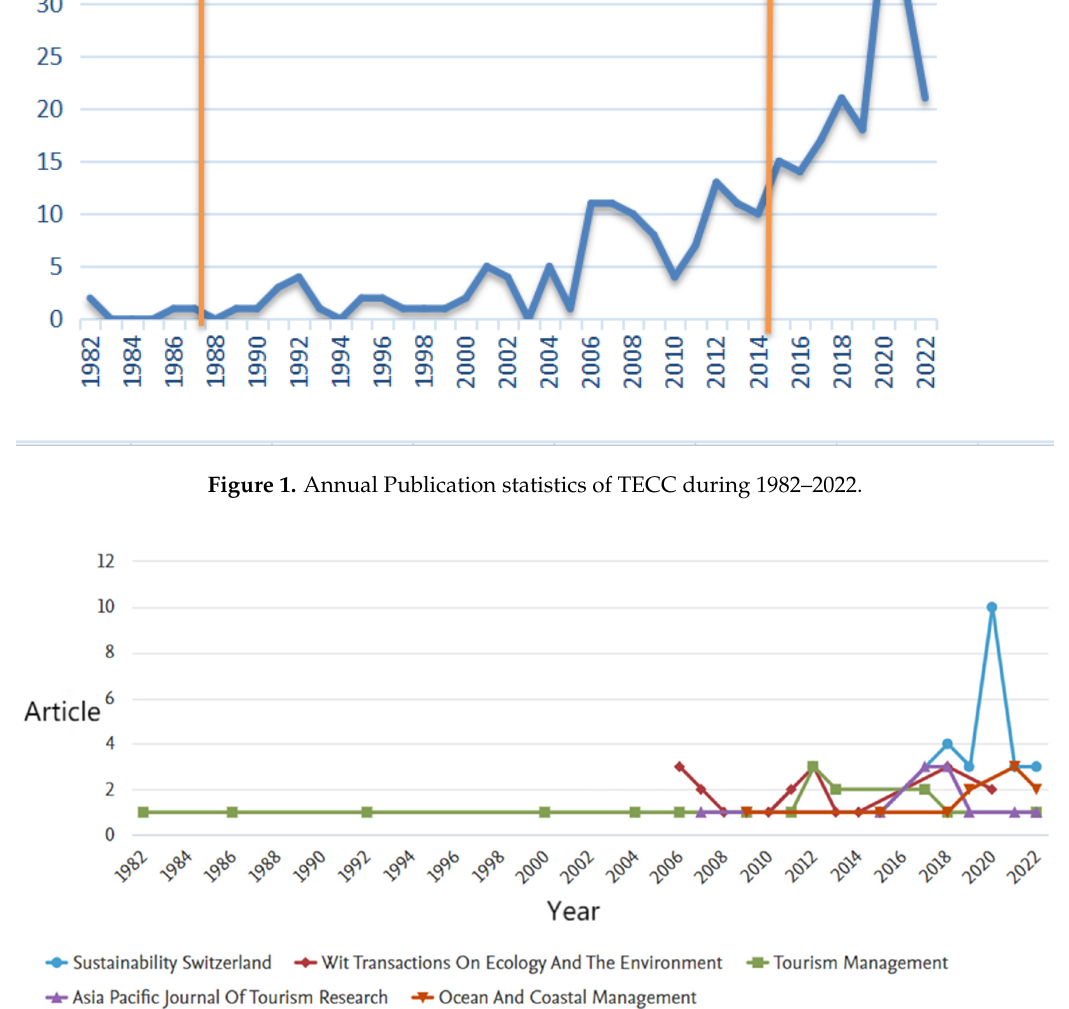
Figure 3. The coupling relationship between journals on the theme of TECC. 3.2. Keyword Co-Occurrence Analysis From the results of the keyword co-occurrence analysis presented in Figure 4, the earlier studies (#7 #8) focused on the TECC measurement of natural tourism destina- tions, including global geoparks [29], national parks [30,31], recreational wetlands [32] and independent islands [33] (#6), while subsequent studies (#5) have sought to change the traditional way of measuring the TECC [34] and exploring integrated measurement methods. In the 21st century, research on TECC is no longer limited to the measurement of physical carrying capacity but also focuses on the impact of variables such as destina- tion perception, tourist satisfaction and resident perception on tourism carrying capacity and introduces social carrying capacity [35,36] (#1). In 2015, with the United Nations Sustainable Development Summit held in New York, scholars increased their attention to the sustainable development of the ocean, and in terms of marine tourism, Catalonia, Spain, has the most abundant tourism resources and is the most popular marine tourism destination, with a large number of tourists from the United Kingdom, Northern Europe and North America throughout the year all seasons, and the study of the environmental